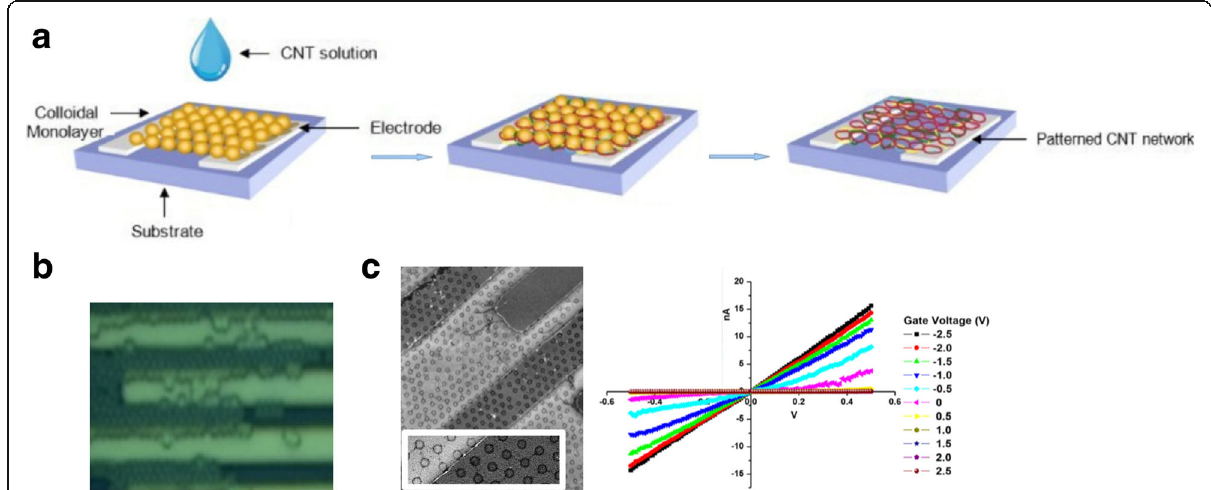
Fig. 40 a Schematic of fabrication process for patterned CNTFET networks. b Optical microscope image of patterned electrode substrates after self-assembled colloidal mask assembly. c SEM image of interconnected nanotube ring patterns formed during the self-assembly process and gate voltage-dependent I - V characteristics of resulting CNTFET. The center to center distance of the circles is around 500 nm. (Inset) shows the corresponding magnified view of the interconnected nanotube ring patterns. [Y. Chen and C. Papadopoulos, unpublished results]